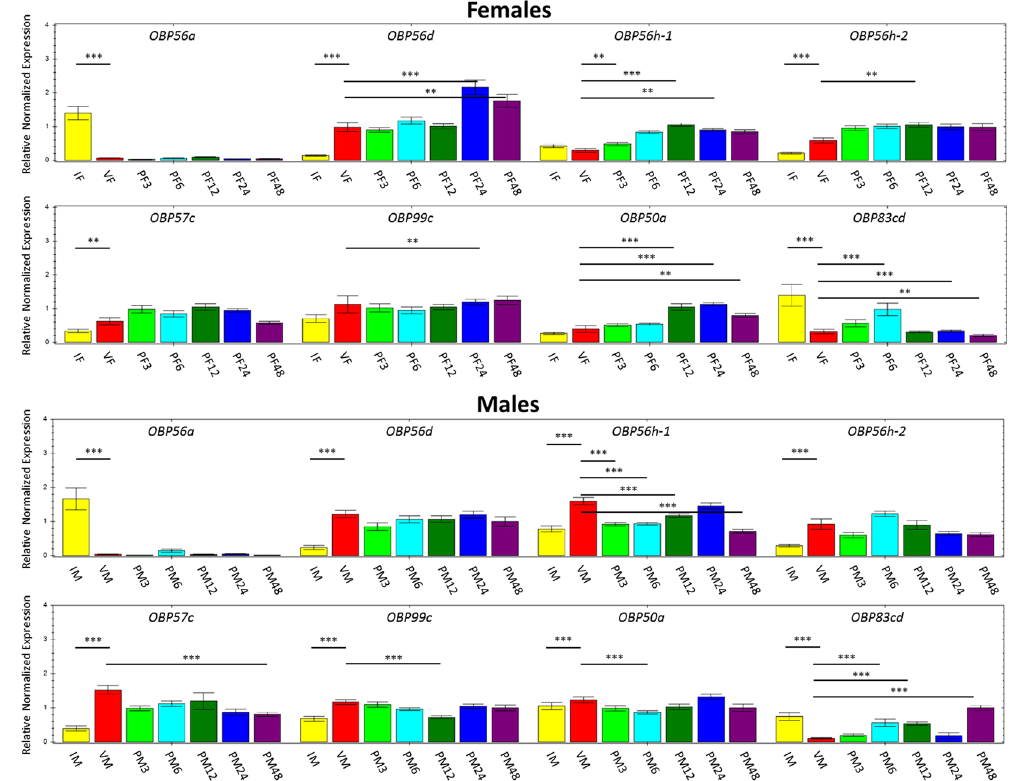
Figure 3. Relative normalized expression of OBP genes in A . obliqua reproductive stages according to qPCR analyses. IF = immature female; VF = virgin female; PF3 = 3 h post-mating female; PF6 = 6 h post- mating female; PF12 = 12 h post-mating female; PF24 = 24 h post-mating female; PF48 = 48 h post-mating female; IM = immature male; VM = virgin male; PM3 = 3 h post-mating male; PM6 = 6 h post-mating male; PM12 = 12 h post-mating male; PM24 = 24 h post-mating male; PM48 = 48 h post-mating male. Pairs of profiles significantly differentially expressed are show at the endpoints of each line above the bars. Unpaired t-test: ** p-value < 0.01; *** p-value <